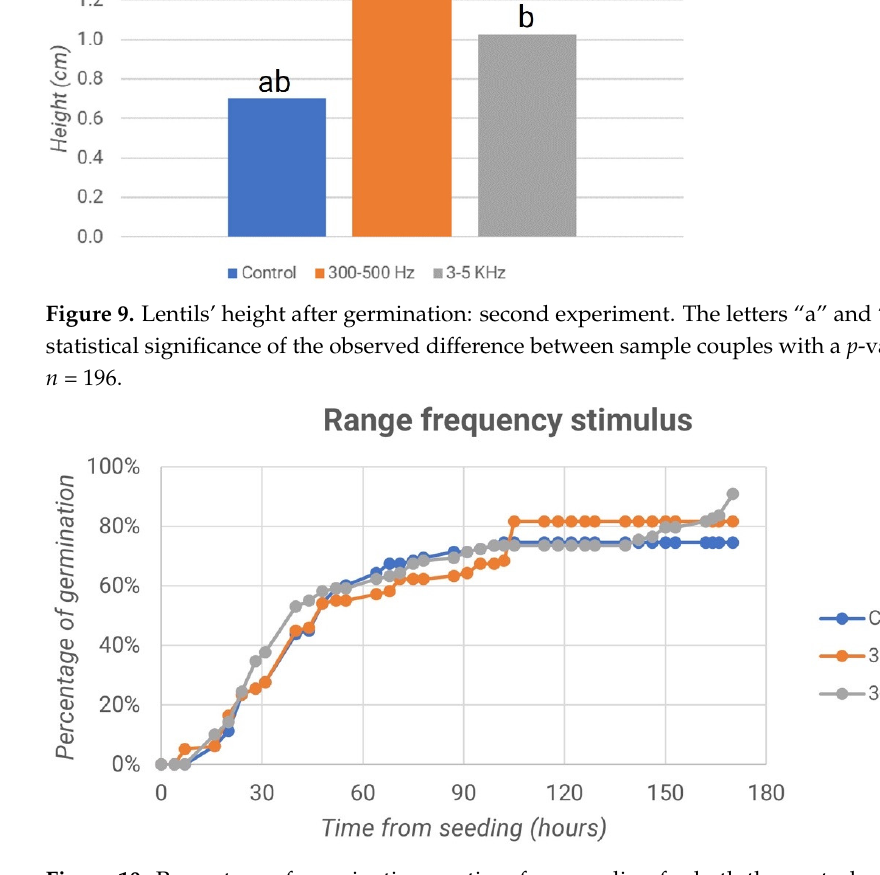
Figure 10. Percentage of germination vs. time from seeding for both the control samples and the samples treated with frequencies of 300–500 Hz and 3–5 kHz: second experiment.